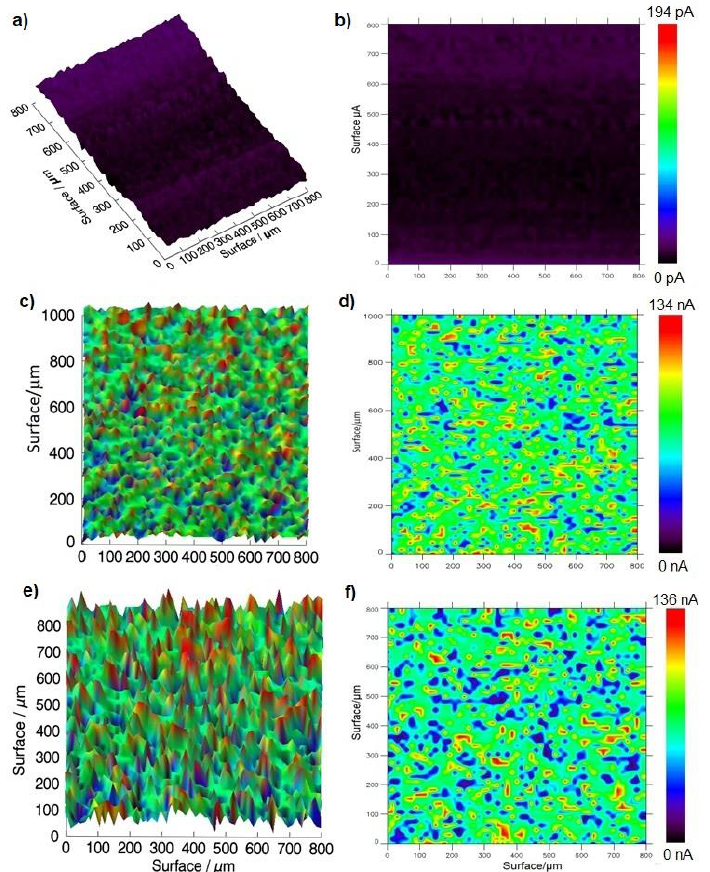
Figure 9. The 3D images (left) and respective plane RGB images (right) of SECM current obtained for a TMPyP/GSH-CdTeQD/GOx modified graphite electrode. ( a , b ) without glucose, ( c , d ) in the presence of glucose 5 mM at 0.7 V vs. SCE for H 2 O 2 determination and ( e , f ) at 0.25 V vs. SCE for the FcMeOH reaction.